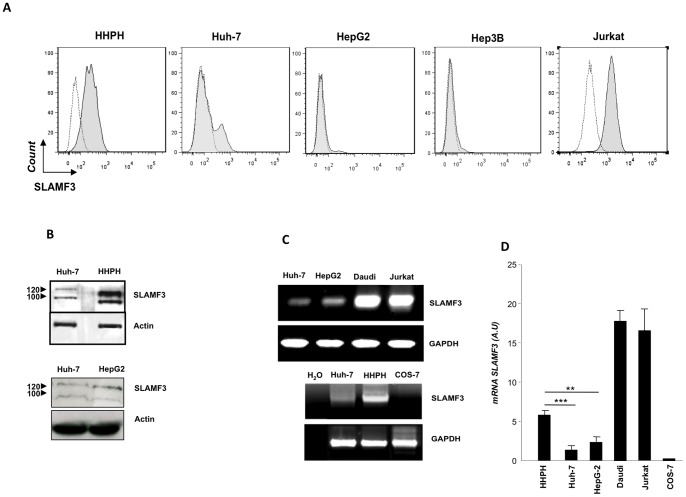
SLAMF3 is expressed by hepatocytes.(A) SLAMF3 expression was analysed by flow cytometry analysis in HHPHs and in Huh-7, HepG2 and Hep3B human HCC cell lines. SLAMF3 expression in Jurkat lymphocytes was used as a positive control; SLAMF3 staining (in grey) is overlaid by the negative control (in white) and corresponds to one representative of five independent experiments. (B) Western blot analysis of proteins extracted from Huh-7 cells, HepG2 cells or HHPHs, with a mAb (K12) against SLAMF3′s first extracellular domain (D1) or an anti-actin antibody as a control. One of four independent experiments is presented here. (C) Expression of SLAMF3 transcripts in hepatocytes. After reverse transcription, SLAMF3 cDNA was amplified by PCR using specific primers. GAPDH was amplified as a control gene and pure H2O was used as a PCR control. The Daudi and Jurkat human lymphocyte cell lines were used as positive controls and the monkey kidney COS-7 cell line was used as a negative control. One of three independent experiments is shown here; (D) SLAMF3 mRNA was assayed by Q-PCR in (i) HHPHs, Huh-7 cells and HepG2 cells, (ii) Daudi B lymphocytes and Jurkat T lymphocytes (positive controls) and (iii) the green monkey kidney COS-7 cell line (a negative control). Results are presented as the mean ± SD (n = 6) ***p<0.005, **p<0.01).